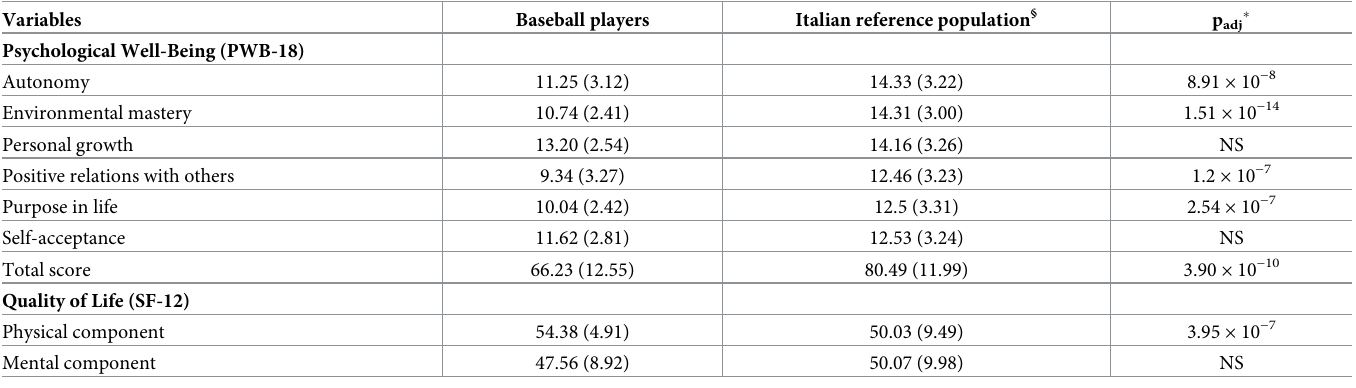
Table 4. Mean scores of psychological well-being scale and quality of life questionnaires in visually impaired baseball players compared with the Italian normally sighted population.